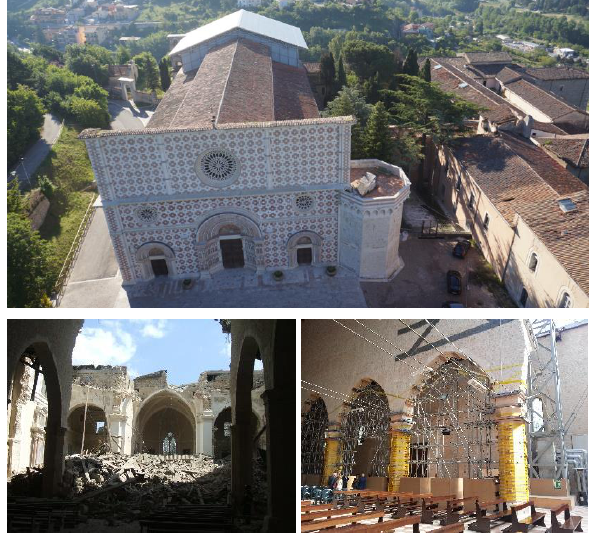
Figure 2. Top: an image of the Basilica acquired with the UAV platform AscTec Falcon 8. Bottom: on the left an image of the transept area immediately after the earthquake in 2009. On the right the consolidation structures to strengthen the octagonal pillars of the naves